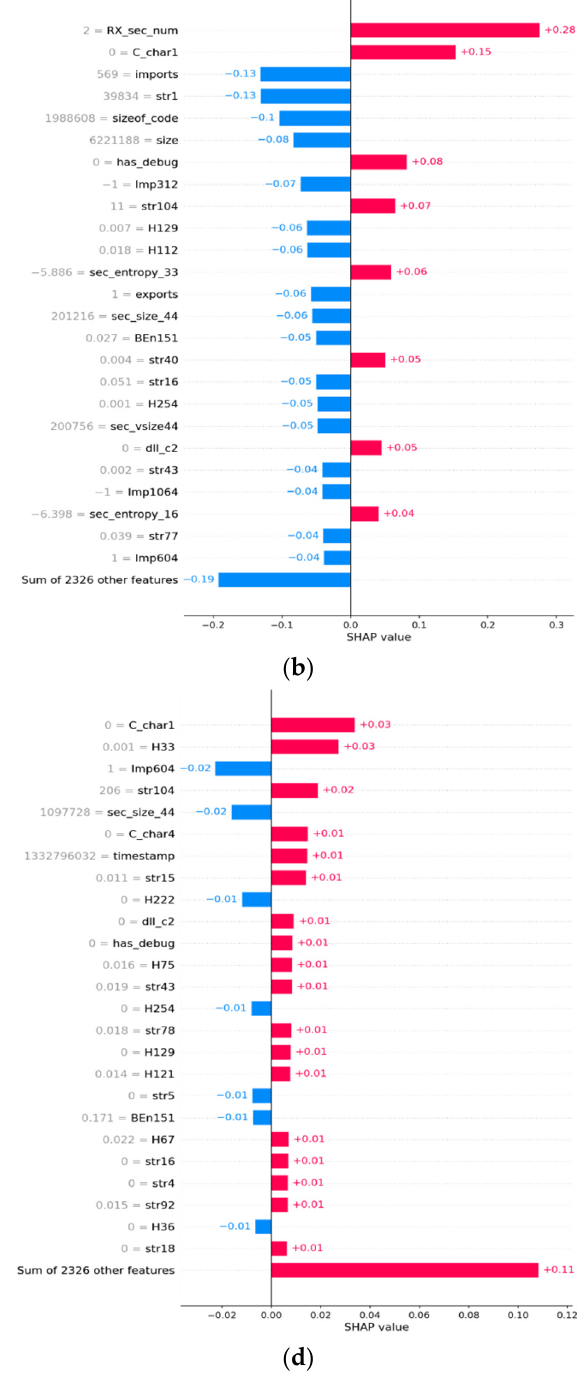
Figure 5. Bar plot of a FP sample ( a ), a FN sample ( b ), a TP sample ( c ), and a TN sample ( d ) from the D2 dataset on probability scale.